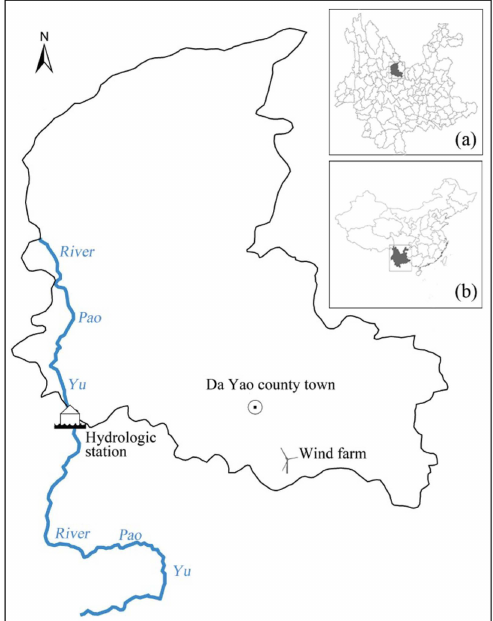
Figure 4. Locations of anemometer tower and hydrologic station. Anemometer tower is located in southern Dayao County in Yunnan Province, China (25 ˝ 36.72 1 N, 101 ˝ 22.88 1 E). Hydrologic station is